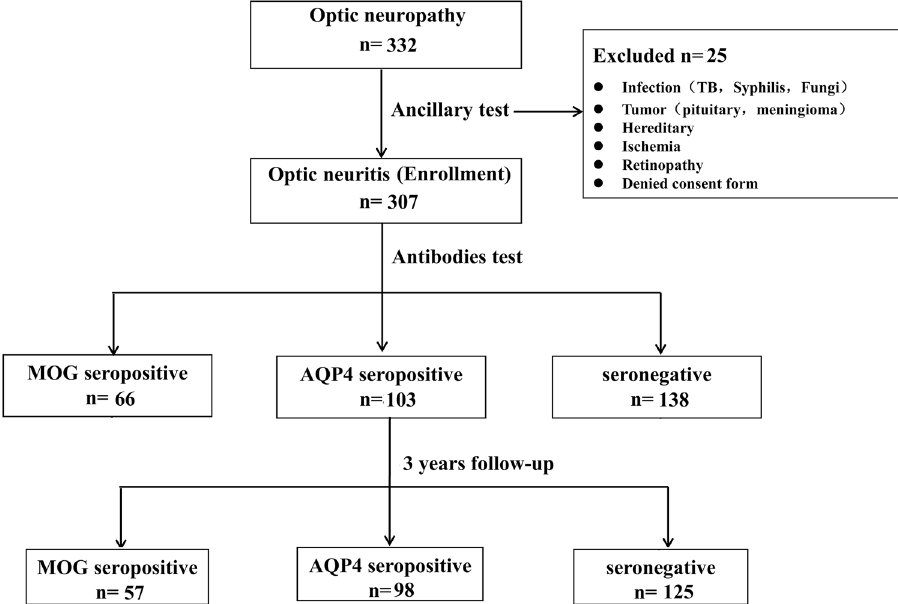
Figure 4. Study diagram and grouping of patients. TB, tuberculosis; MOG, myelin oligodendrocyte glycoprotein; ON, optic neuritis; AQP-4, aquaporin